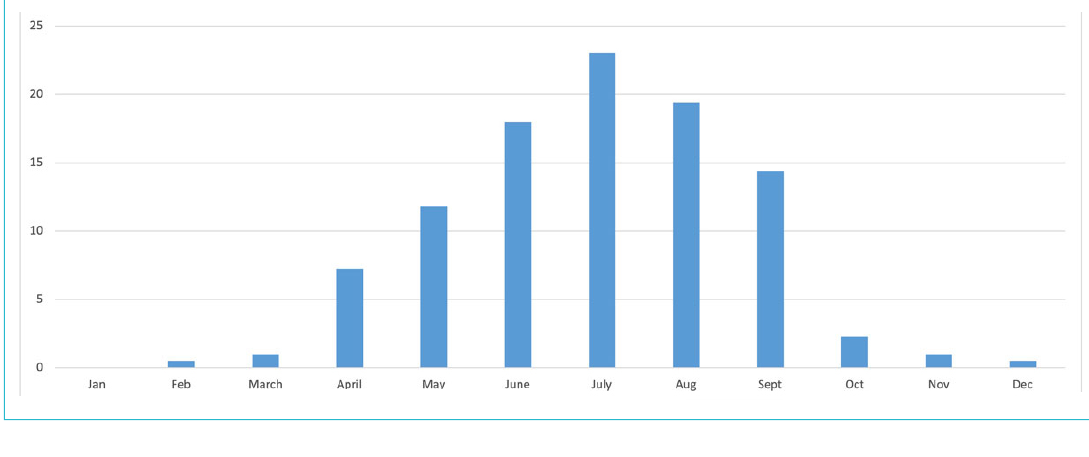
Figure 4: Seasonal distribution of indigenous venomous snakebites in Switzerland 1997–2018.